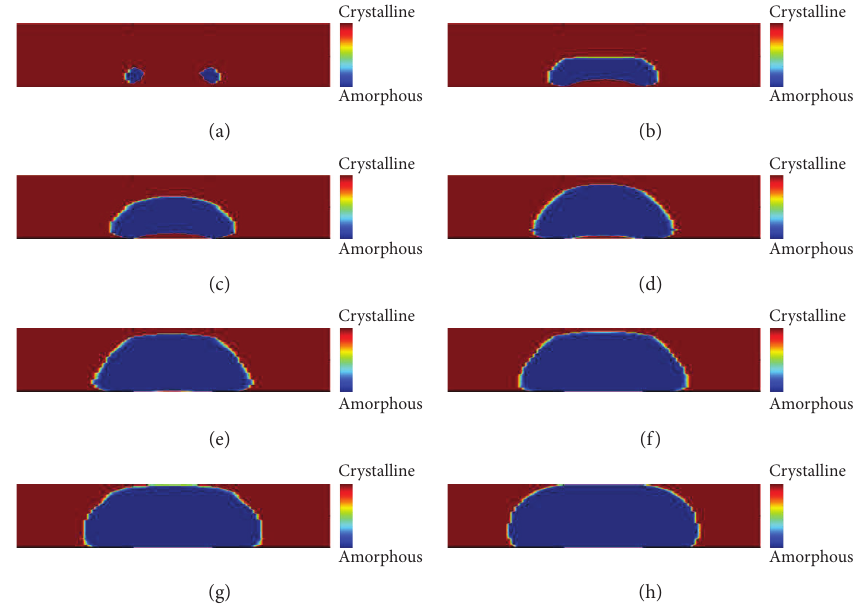
Figure 7: Phase distribution of simulation 1. The phase distribution of GSTafter imposing the pulses with amplitudes of (a) 1.6V, (b) 1.8V, (c) 2.0V, (d) 2.4V, (e) 2.8 V, (f) 3.2V, (g) 3.8 V, and (h) 4.6 V on the resistance change unit, respectively.